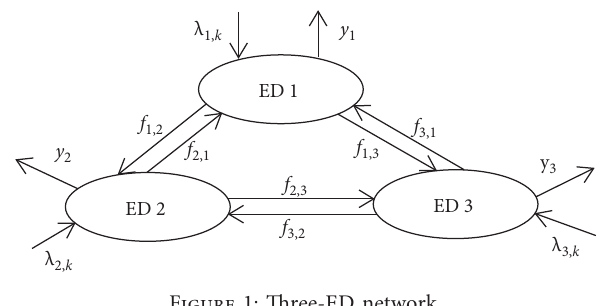
Figure 1: Three-ED